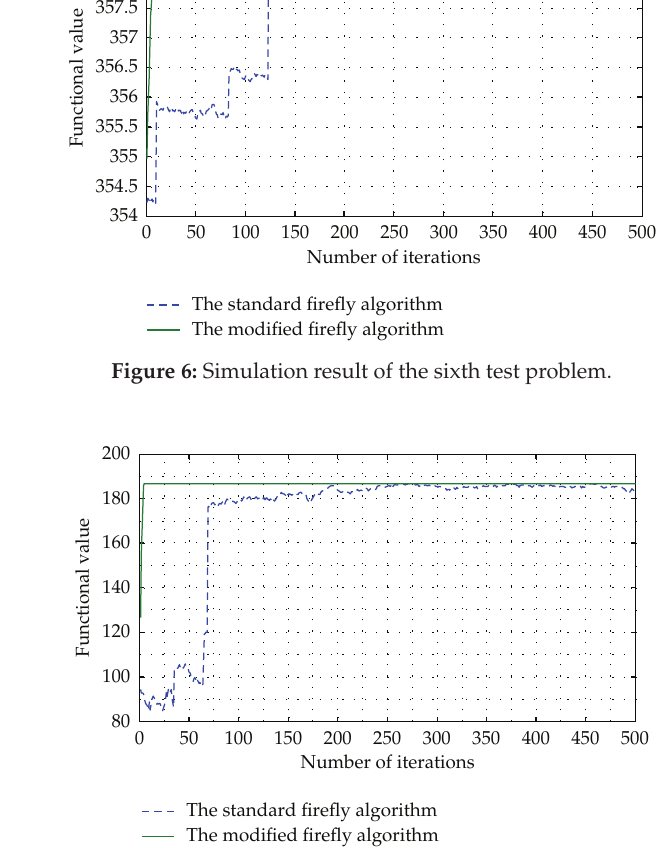
Figure 7: Simulation result of the seventh test